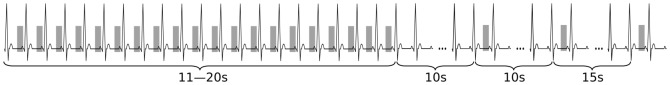
Image acquisition protocol for 4D CT myocardial perfusion analysis.Image acquisition (gray area) is done in each RR-interval during the first 11–. These 11– are called dynamic phase. The length depends on the heart rate with the aim to cover up to 20 RR-intervals. Three additional single acquisitions (late phases) are done , , and  after the dynamic phase.